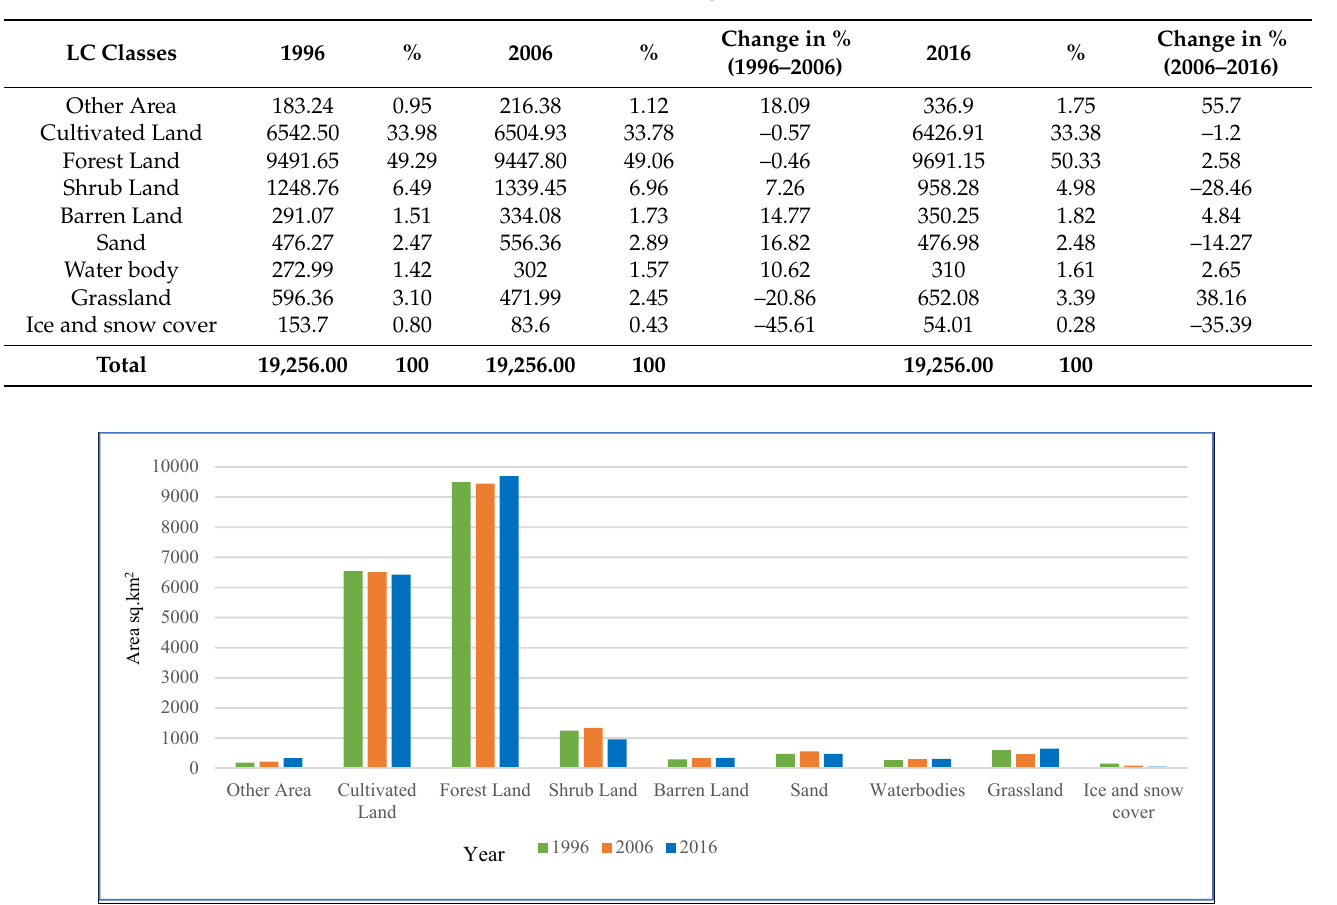
Table 4. Distributions of LULC change between 1996 and 2016.